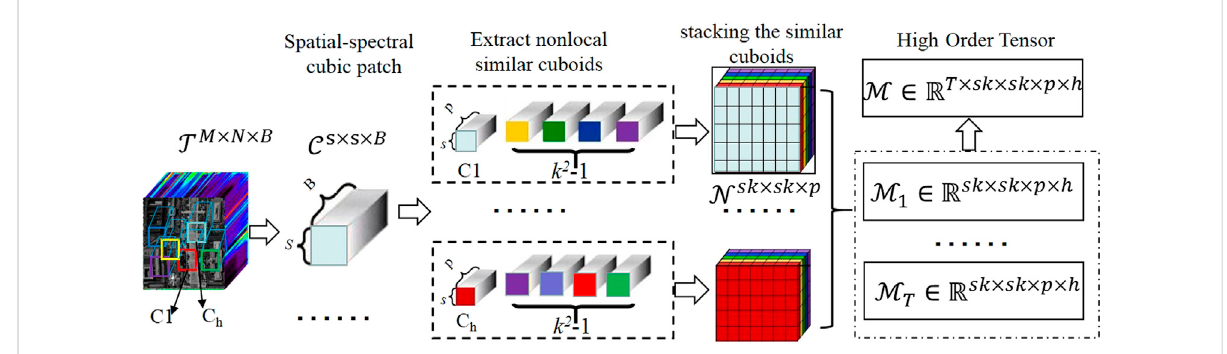
FIGURE 2 Illustration of the procedure to construct a high-order tensor by spatial and spectral similarities of HSI.